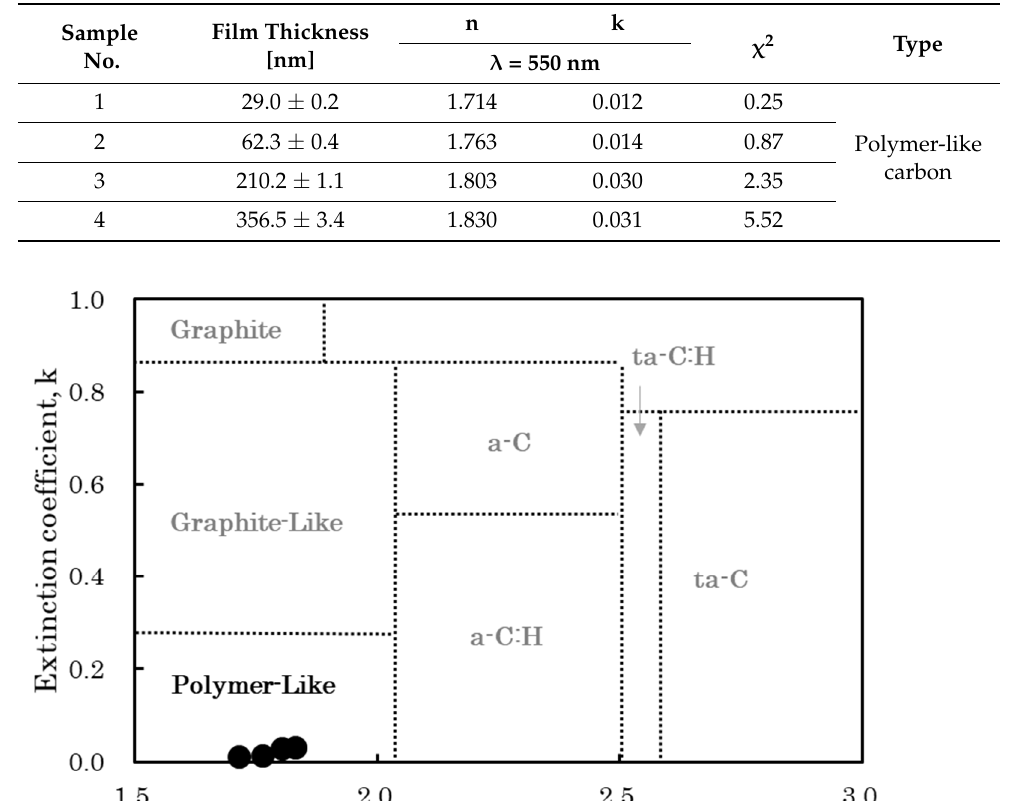
Table 3. PLC film thickness and optical constants determined via spectroscopic ellipsometer analysis.